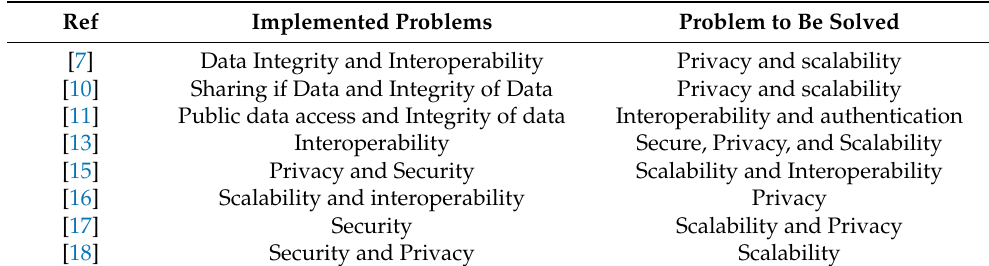
Table 2. Several solutions of the existing techniques EHR systems currently lack adequate interop- erability to provide private, effective, and secure access control.